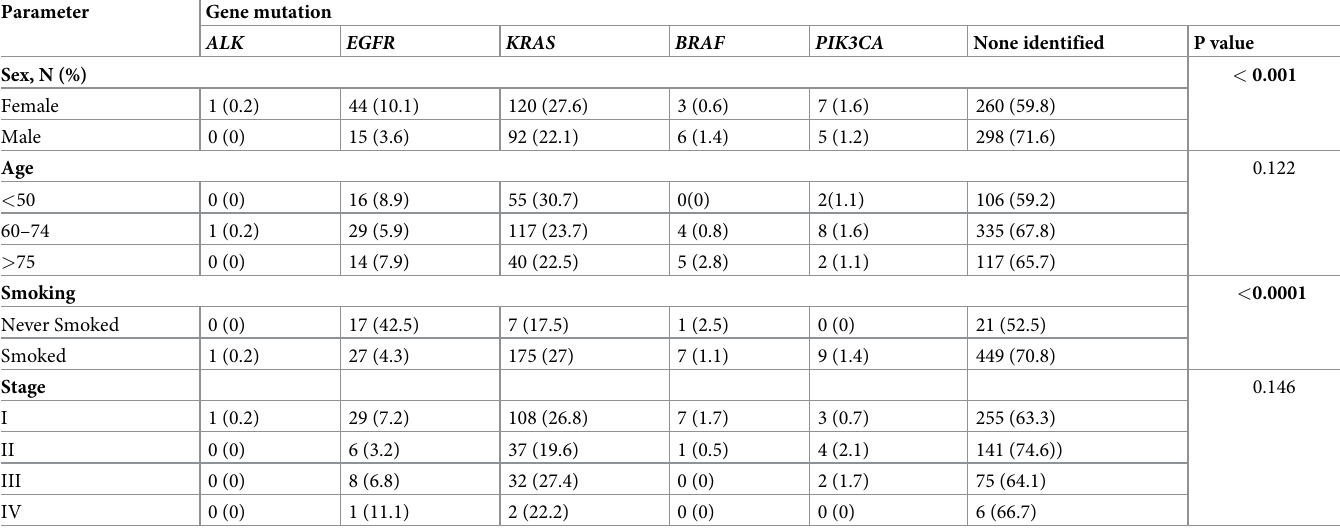
Table 3. Clinical characteristics of patients with NSCLC (N = 851) and their relationship with the most common gene mutations. Parameter Gene